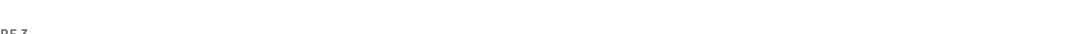
FIGURE3 homogenate relative to 5xFAD uninjected mice ( n = 5). Data were normalized to the housekeeping gene Actb . Mean ± SEM, unpaired non-parametric t -test (Mann–Whitney), * p < 0.05, ** p < 0.01. (E) Gene expression of the chemokines Cxcl10 and Ccl5 as well as Apoe in 5xFAD animals with WT ( n = 5) or 5xFAD ( n = 5) homogenate relative to uninjected 5xFAD mice ( n = 5). Data were normalized to Actb . Mean ± SEM, unpaired non-parametric t -test (Mann–Whitney), * p < 0.05, ** p < 0.01. (F) Quantification of the ratio between GFAP signal and GFAP and C3 co-localizing signal in the CC of 5xFAD animals, either uninjected or injected with WT or 5xFAD homogenate. n = 4–6 mice with n = 4–5 sections analyzed per animal. Mean ± SEM, two-way ANOVA followed by Tukey’s multiple comparison test, * p < 0.05, *** p < 0.0005. (G) Confocal images of GFAP (green), C3 (red), and 6E10 (white) of 5xFAD mice, either not injected or injected with 5xFAD brain extract. Dashed line marks the CC. Abbreviations: Ctx, cortex; CA1, hippocampal CA1 region; CC, corpus callosum. Scale bar 50 µ